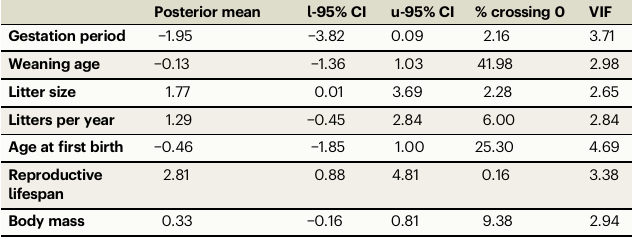
Table 5 | Life history predictors of introduction within traded mammals from probit